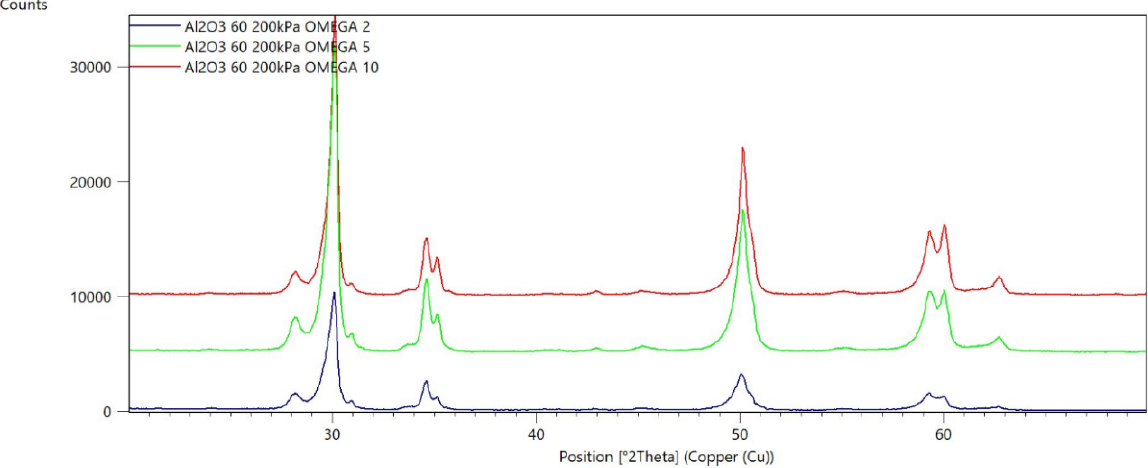
Figure 3. Diffraction patterns of sample B (abrasive—Al 2 O 3 60 μ m, pressure 400 kPa). Figure 4. Diffraction patterns of sample C (abrasive—Al 2 O 3 110 μ m, pressure 200 kPa).